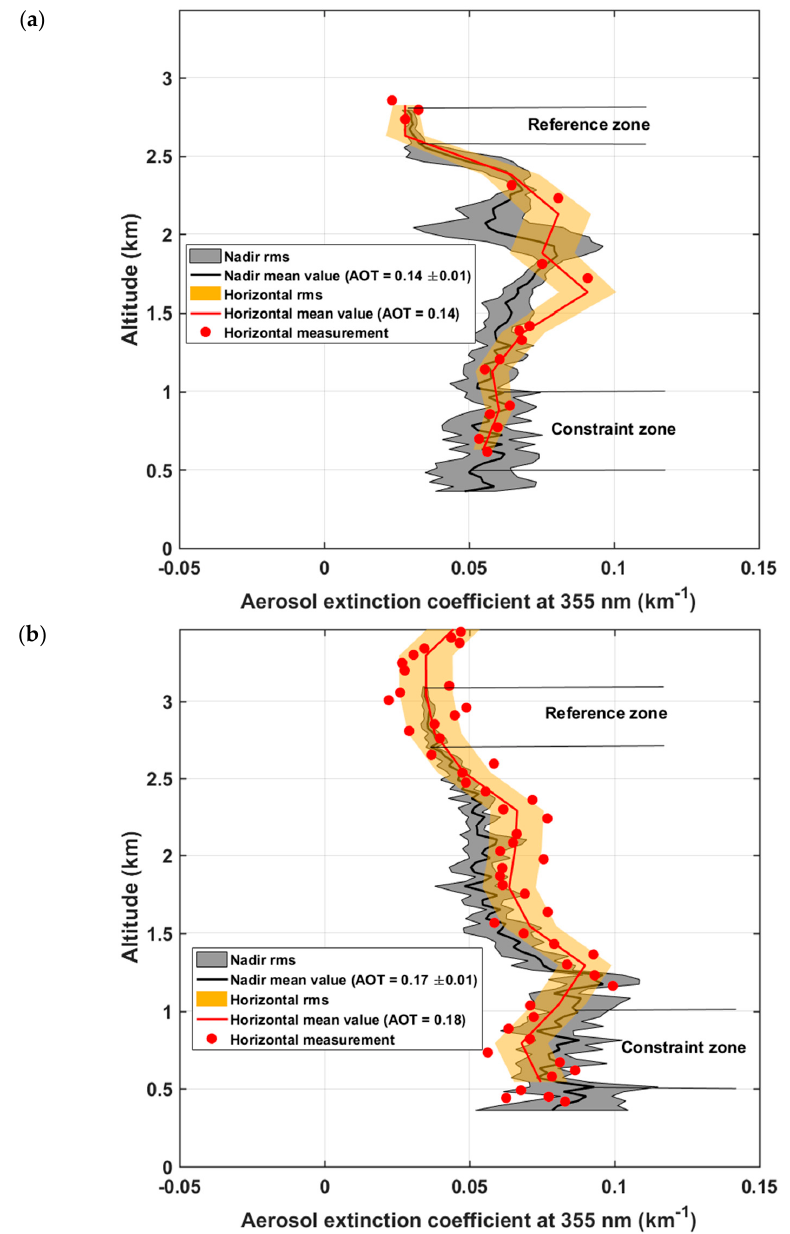
Figure 5. Vertical profiles of the aerosol extinction coefficient derived from the horizontal and nadir Lidar shootings for: ( a ) flight A on 18th of June for a planetary boundary layer (PBL) height of between 1.6 and 1.9 km above the mean sea level (amsl) and ( b ) flight B on 22nd of June for a PBL height of ~1.25 km amsl. The standard deviations are represented by the shaded areas. The nadir profiles are averaged over ~2 min. Each horizontal measurement of aerosol extinction coefficient is obtained over 20 s, between ~0.3 and 0.8 km from the ULA.